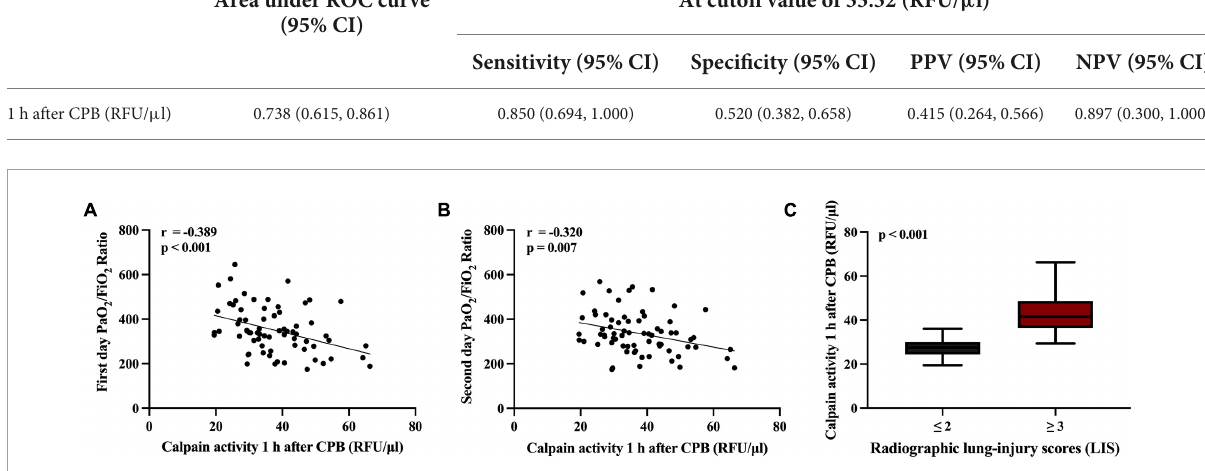
FIGURE4 Scatterplot displaying the relation between serum level of calpains 1 h after cardiopulmonary bypass (CPB) and the inspiratory oxygen fraction to oxygen pressure (PaO 2 /FiO 2 ) ratio at first 2 days (A,B) , and radiographic lung-injury scores (LIS) (C) .